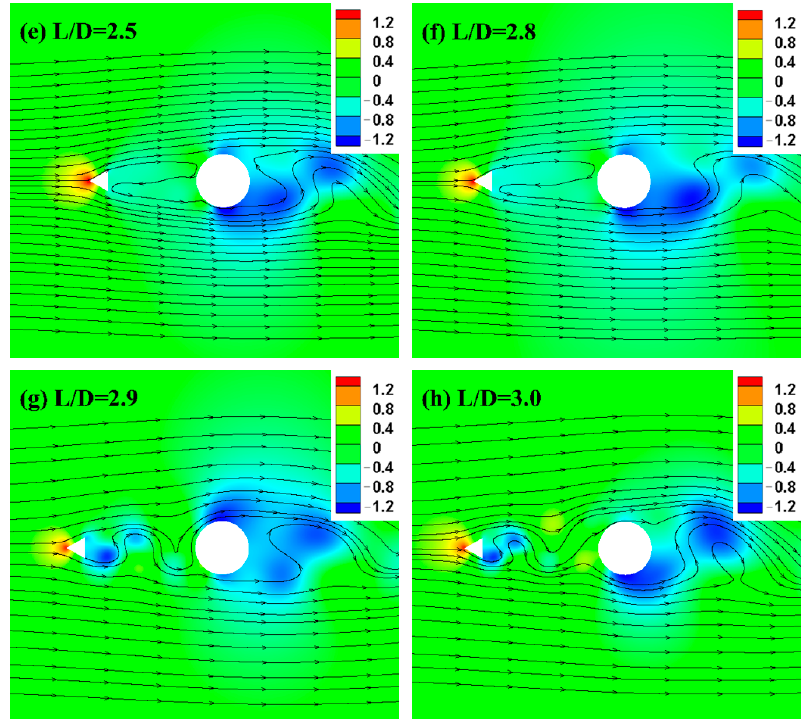
Figure 5. Contours of pressure field and streamline in the vicinity of the main cylinder for different spacing ratios, as represented by L / D, ( a ) isolated smooth cylinder; ( b ) L / D = 1.0; ( c ) L / D = 1.5; ( d ) L / D = 2.0; ( e ) L / D = 2.5; ( f ) L / D = 2.8; ( g ) L / D = 2.9; ( h ) L / D = 3.0.